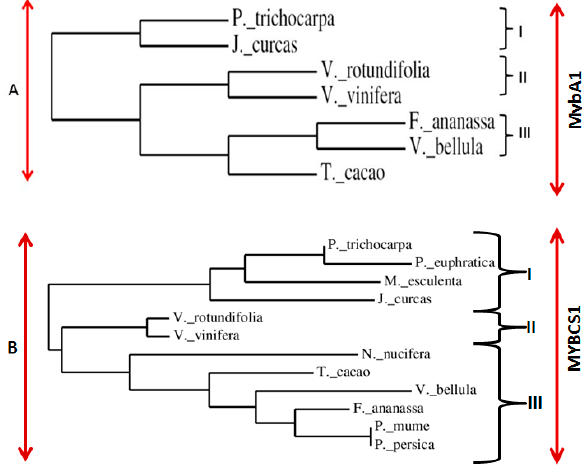
Figure 5. Comparison of the deduced amino acid sequences of R2R3-type MYB transcription factors from higher plants. ( A ) A phylogenetic tree for plant MybA1 transcription factors; ( B ) A phylogenetic tree for plant MYBCS1 transcription factors including the one isolated from muscadine grapes ( V. rotundifolia ) in the present study.